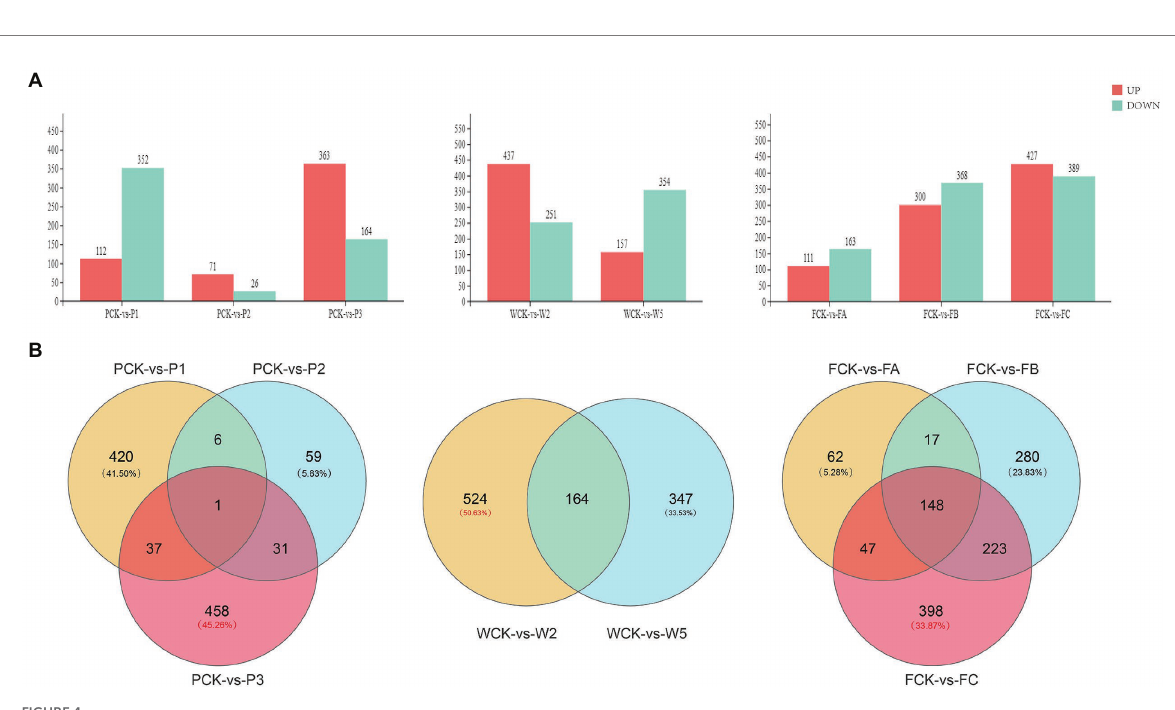
FIGURE 4 Differentially expressed genes (DEGs) in the leaves of Quercus mongolica under different cultivation measures. (A) The number of DEGs. (B) A Venn diagram representation of the number of